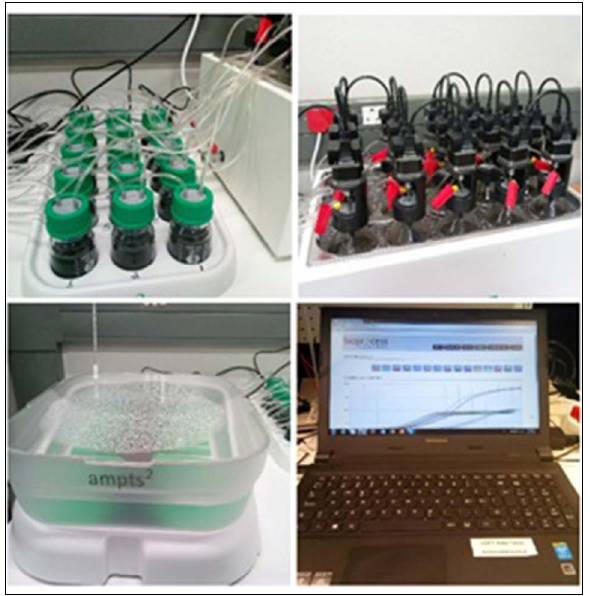
Biomethane potential assay with the data acquisition